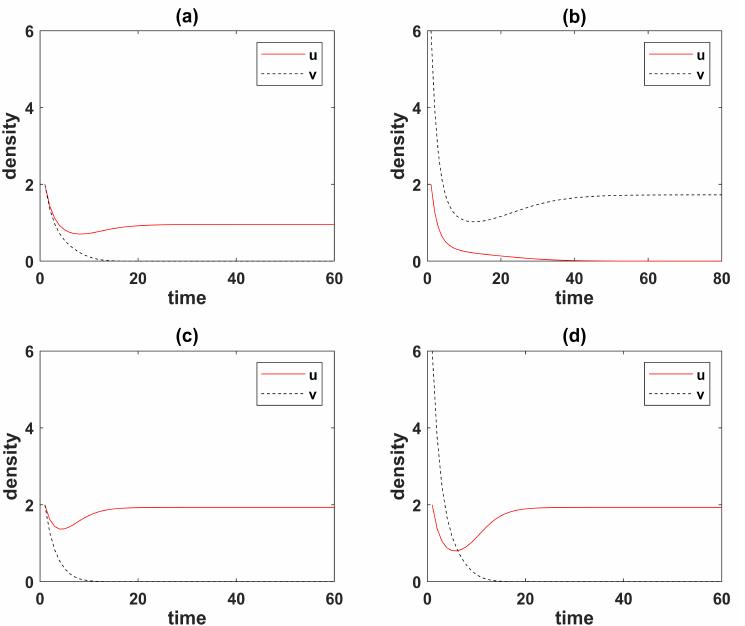
Figure 3. Time series of the spatially averaged densities of Wolbachia -infected populations (red solid) and uninfected populations (black dotted) of the spatial implicit model with common parameters ¯ S ¯ S u = 0.9, v = 0.8, α = β = 1, d 1 = 0.4, d 2 = 0.3. The remaining parameters of the graphs ( a ) and ( b ) are b 1 = 1, b 2 = 1.5, i.e., at point P 1 . This is the founder control case, where the series converges to locally asymptotically stable states E ∗ and E ∗ at suitable initial values of ( 2,2 ) in graphs ( a ) and ( 2,6 ) 2 1 in graphs ( b ), respectively. The bottom two graphs ( c ) and ( d ) depict that, at point P 2 ( b 1 = 1.5, b 2 = 1), the series starting from different initial values (respectively, the same as above them) tend to the globally asymptotically stable state E ∗ . These numerical results are implemented by 1